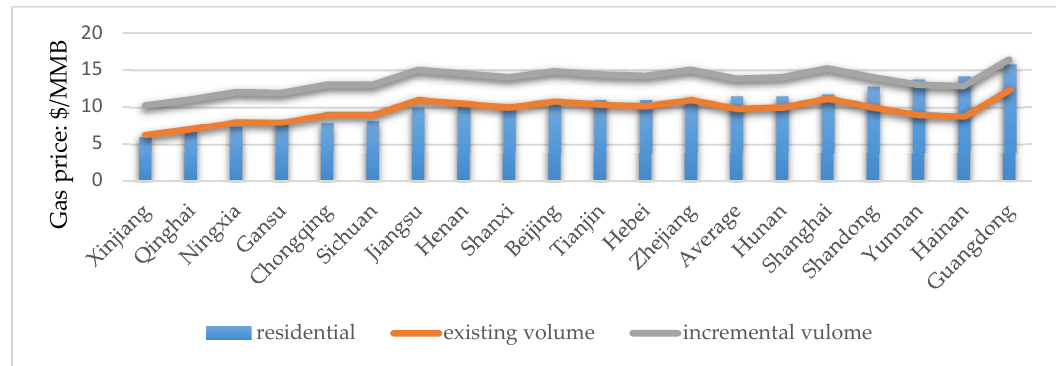
Figure 16. The natural gas supply prices in 20 provinces.